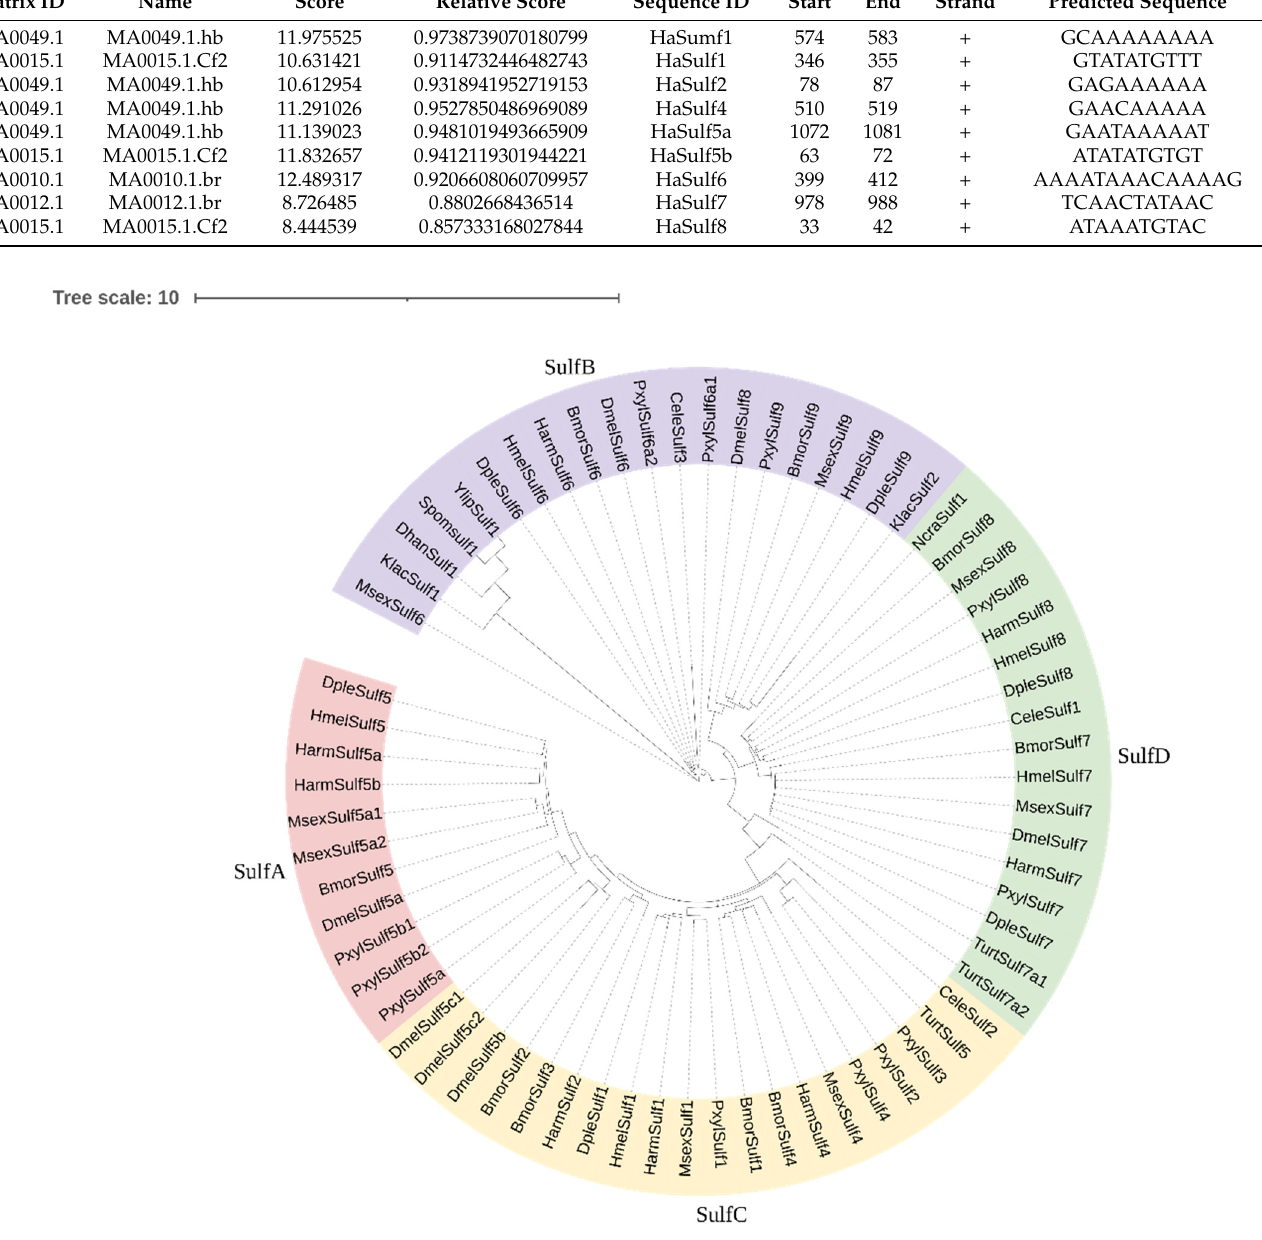
Figure 4. Phylogenetic tree of HaSulf amino acid sequence. Table 2. Identification of HaSumf1 and HaSulfs.